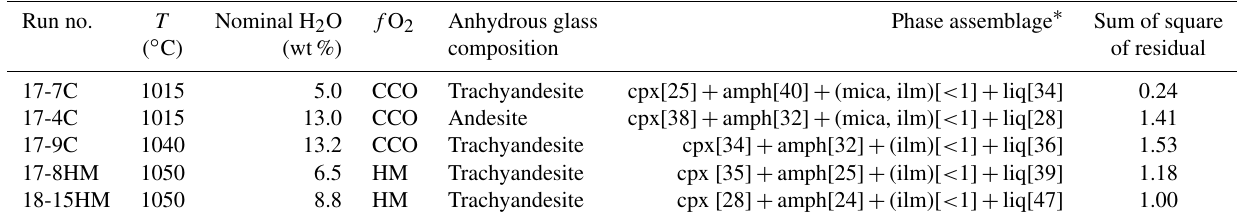
Table 1. Run conditions and phase assemblages for all the experiments. Run no. Nominal H 2 O f O 2 Anhydrous glass Phase assemblage ∗ Sum of square composition of